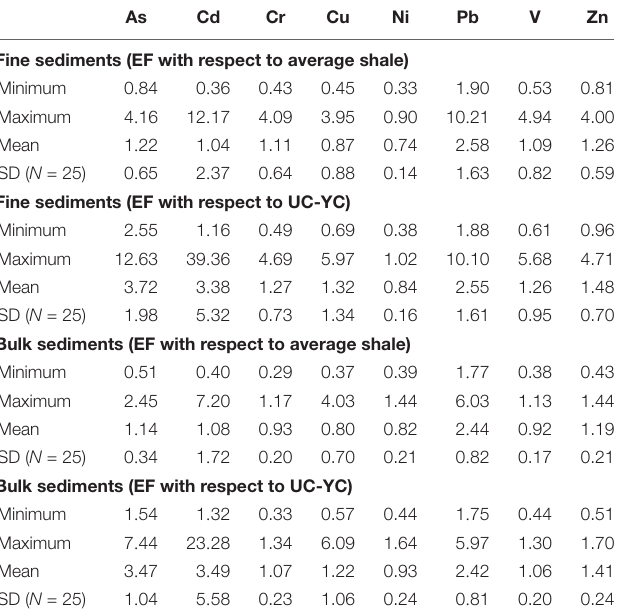
TABLE 5 | Summary statistics of enrichment factor (EF) calculated with respect to average shale (Turekian and Wedepohl, 1961) and the upper crust of Yangtze Craton (UC-YC; Gao et al., 1998) for coastal surface sediments from the northwest coast of Hainan Island. See section Normalization and Enrichment Factors for the calculation of EF.